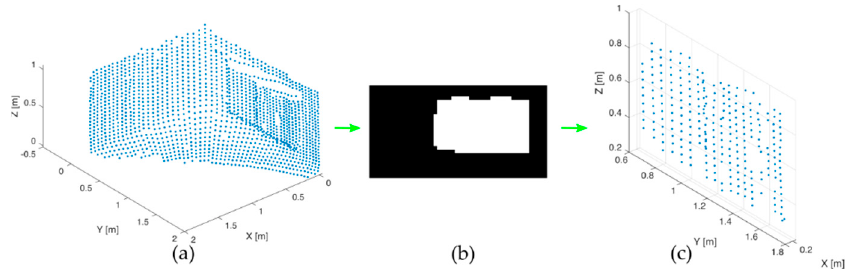
Figure 23. Point cloud segmentation by the level image: ( a ) Input point cloud; ( b ) Input level image; ( c ) Point cloud of the segmented planar surface.